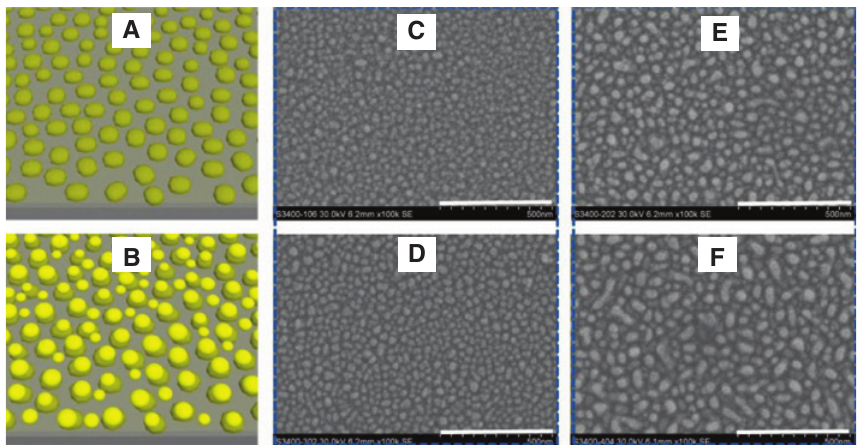
Figure 2: Schematics and scanning electron microscopy (SEM) images of the dielectric film sandwiched plasmonic particles. Schematic of single layer Au particles (A) and dual-layer Au particles with an ultra-thin silicon film (B). (C) (D) Dual-layer Au particles with a 10 nm silicon and silica film, respectively. (E) (F) Dual-layer Au particles with a 30 nm silicon and silica film, respectively. The scale bar is 500